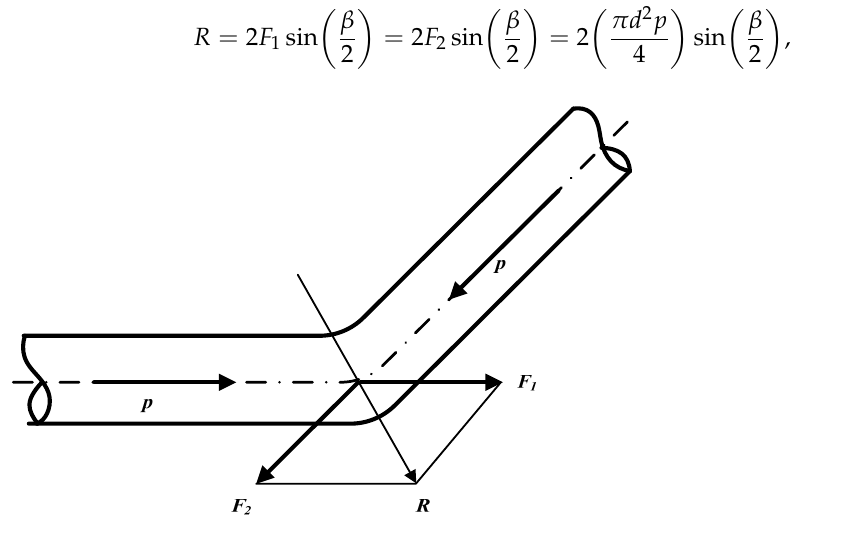
Figure 2. Elbow force